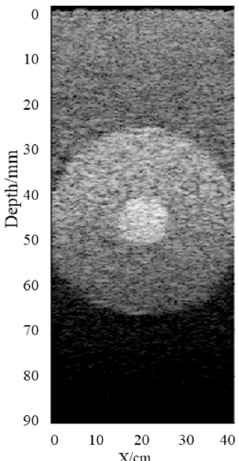
Figure 3. The transmit–receive scheme [21,28]. ( a ) The single plane wave transmit method. ( b ) Radio frequency (RF) signals. ( c ) The beamforming procedure in the receiving mode.